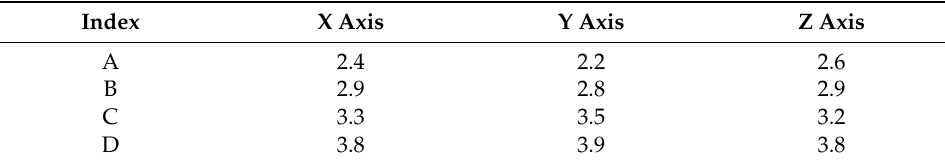
Table 4. Angular velocity vectors of the star sensor.